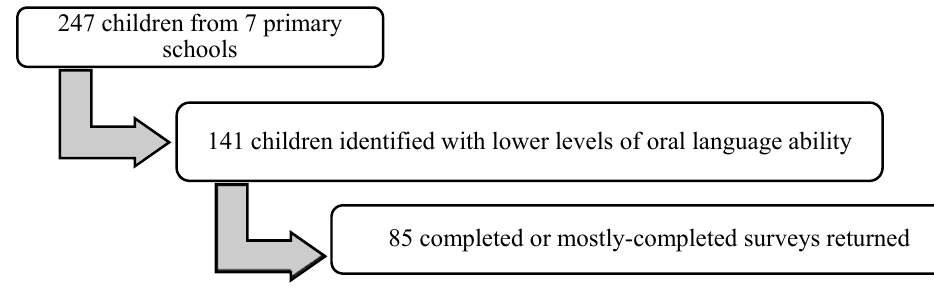
Figure 2. Visual representation of staged recruitment process of the wh ā nau survey.